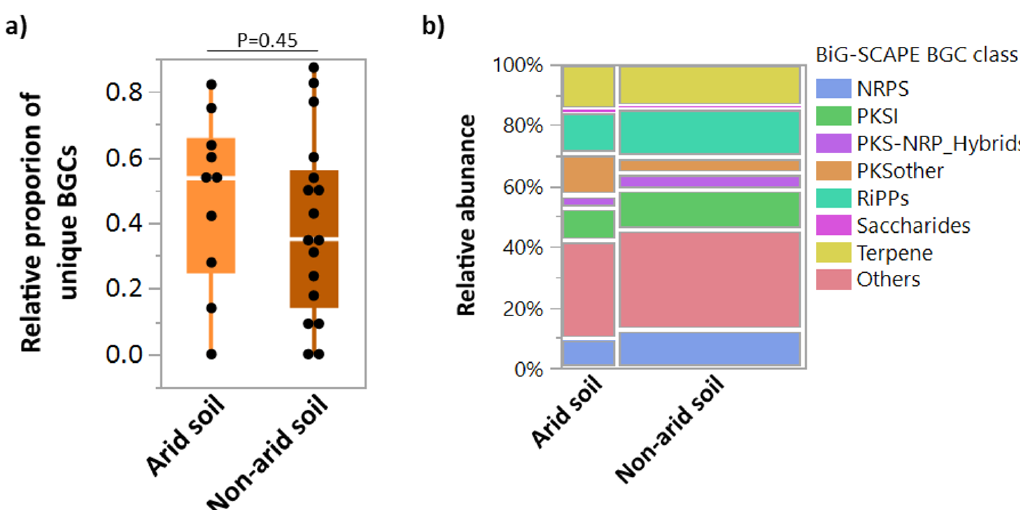
Figure 3. Relative abundance and BGC class distribution in arid soil and non-arid Streptomyces . The BGCs database was constructed with 6556 BGCs detected by atiSMASH 5.0 using 191 public Streptomyces genome assemblies isolated from different environments. Box plot shows relative proportion of unique BCGs in arid-soil derived Streptomyces in comparison to non-arid counterparts ( a ). Mosaic plot showing relative abundance of different BGC classes in the genome assemblies of arid and non-arid-based Streptomyces ( b